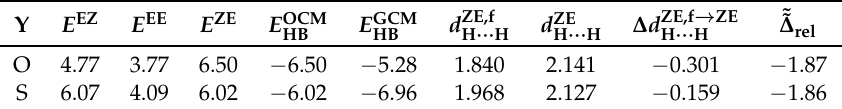
Table 2. Some energetic (in kcal/mol) and geometric (in Å) parameters computed (MP2/6-311++G**) for different forms of 3-aminoacrolein (Y = O) and 3-aminopropential (Y = S). Y E EZ E EE E ZE E OCM